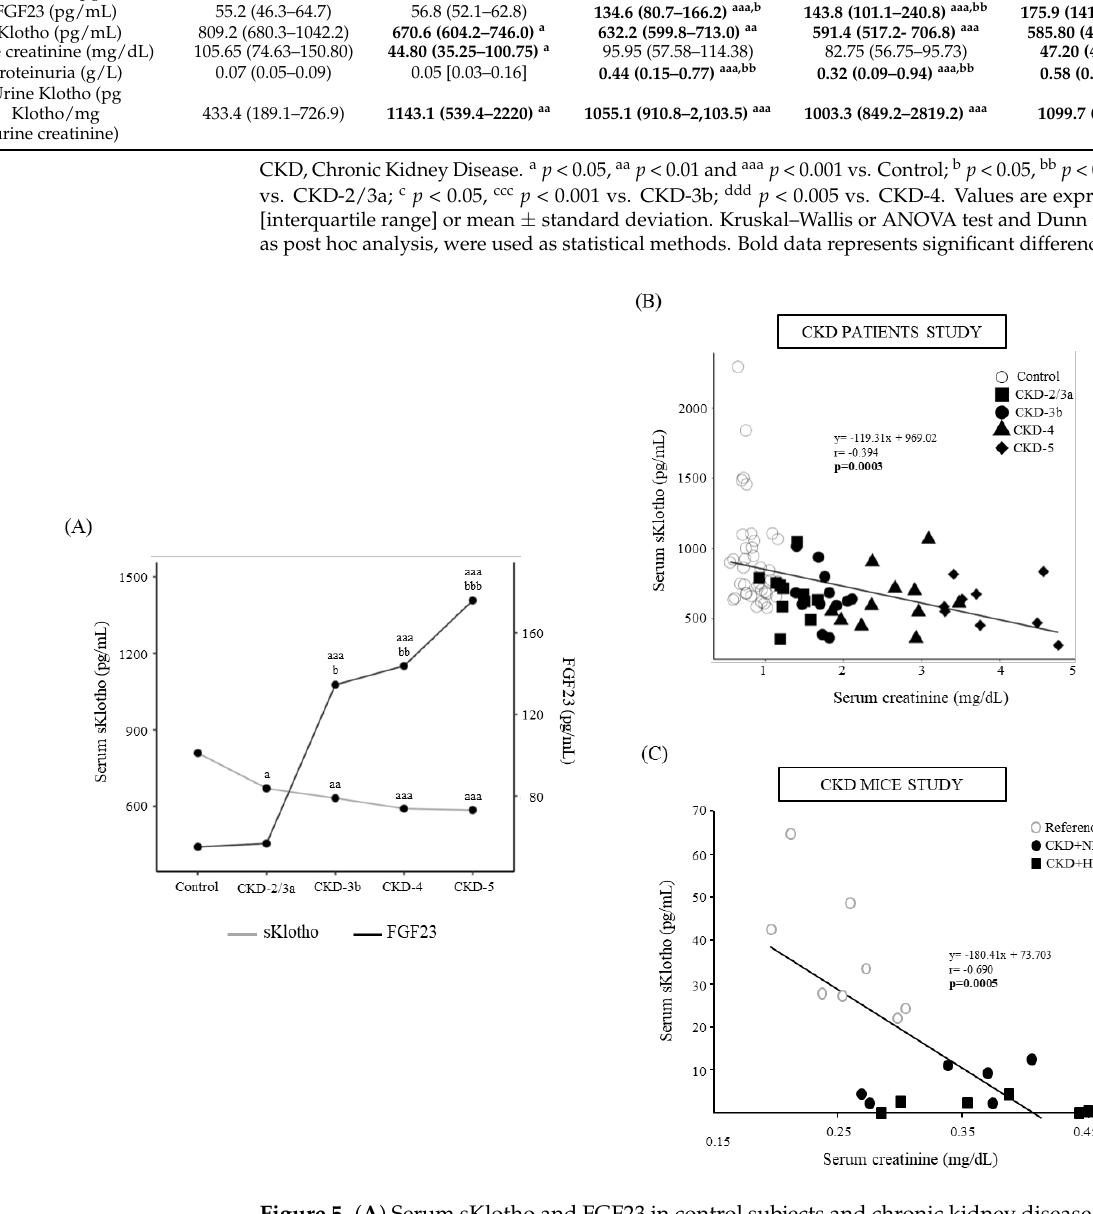
Figure 5. ( A ) Serum sKlotho and FGF23 in control subjects and chronic kidney disease (CKD) patients distributed according to eGFR from KDIGO guidelines. Median are shown. a p < 0.05, aa p < 0.01, aaa p < 0.005 vs. Control, b p < 0.05, bb p < 0.01, bbb p < 0.005 vs. CKD-2/3a. Correlation between serum sKlotho and serum creatinine in ( B ) the individuals described in ( A ). Each shape represents Control ( ○ ), CKD-2/3a ( ■ ), CKD-3b (●), CKD-4 ( ▲ ) and CKD-5 ( ♦ ) values; and in ( C ) Sham-operated mice fed normal phosphorus (NP) (Reference) and CKD mice fed NP or high phosphorus (HP) diet for 14 weeks, each shape represents Reference ( ), CRF+NP ( • ) and CRF+HP ( (cid:4) ) (cid:35)